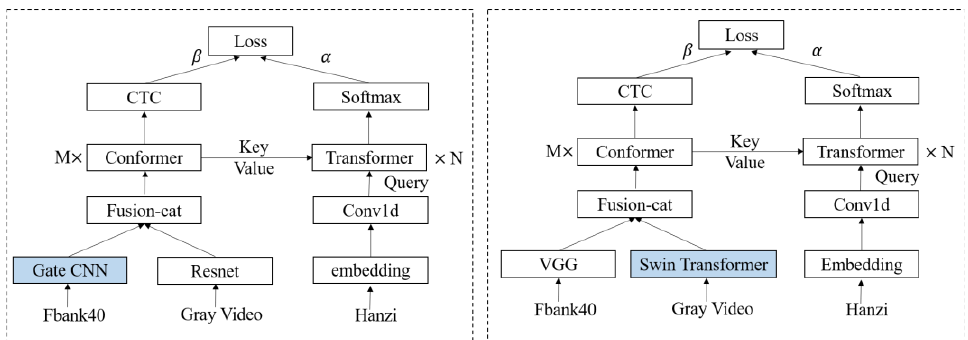
Figure 5. Exploration of model architectures of audio and visual embedding extractor.